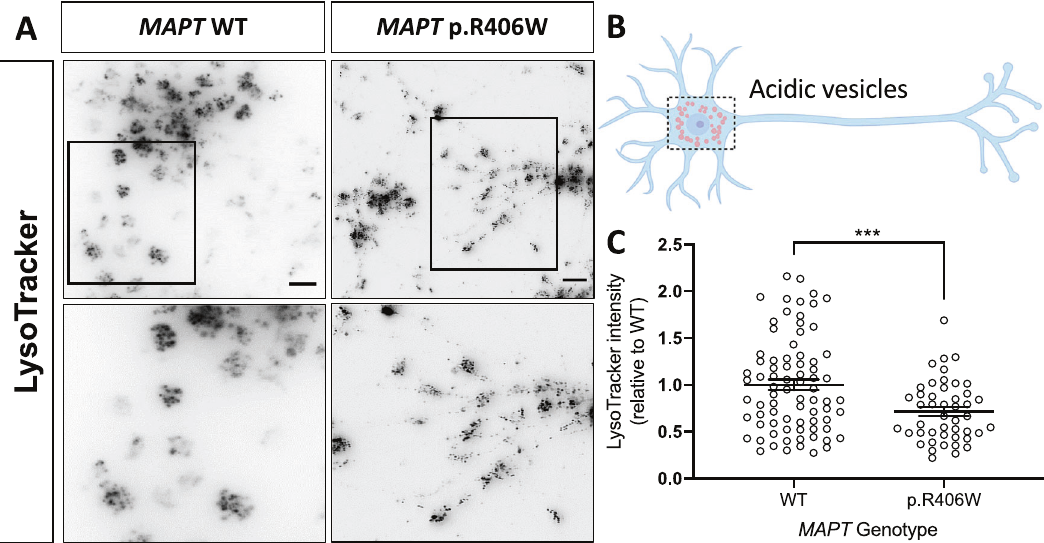
Fig. 4 Human iPSC-neurons expressing the MAPT p.R406W mutation display defects in vesicle acidity. Human iPSC-neurons neurons from a MAPT p.R406W mutation carrier and isogenic, CRISPR/Cas9-corrected control (wild-type (WT)) were differentiated into cortical neurons and cultured for 6 weeks prior to analysis. A MAPT p.R406W neurons exhibit reduced LysoTracker staining. Live cells were incubated with Lysotracker and were imaged as described in Methods. Representative images of LysoTracker-stained neurons are shown in gray scale for clarity. Scale bar, 10 microns. Lower panel represents magni fi cation of the cells in the black box. B Schematic of the quanti fi cation of LysoTracker staining in MAPT p.R406W neurons ( n = 78 cells) and isogenic controls ( n = 46 cells). C Quanti fi cation of the intensity of LysoTracker staining in individual soma. Graphs represent mean ± SEM. Signi fi cance was determined using an unpaired, t -test. *** p <